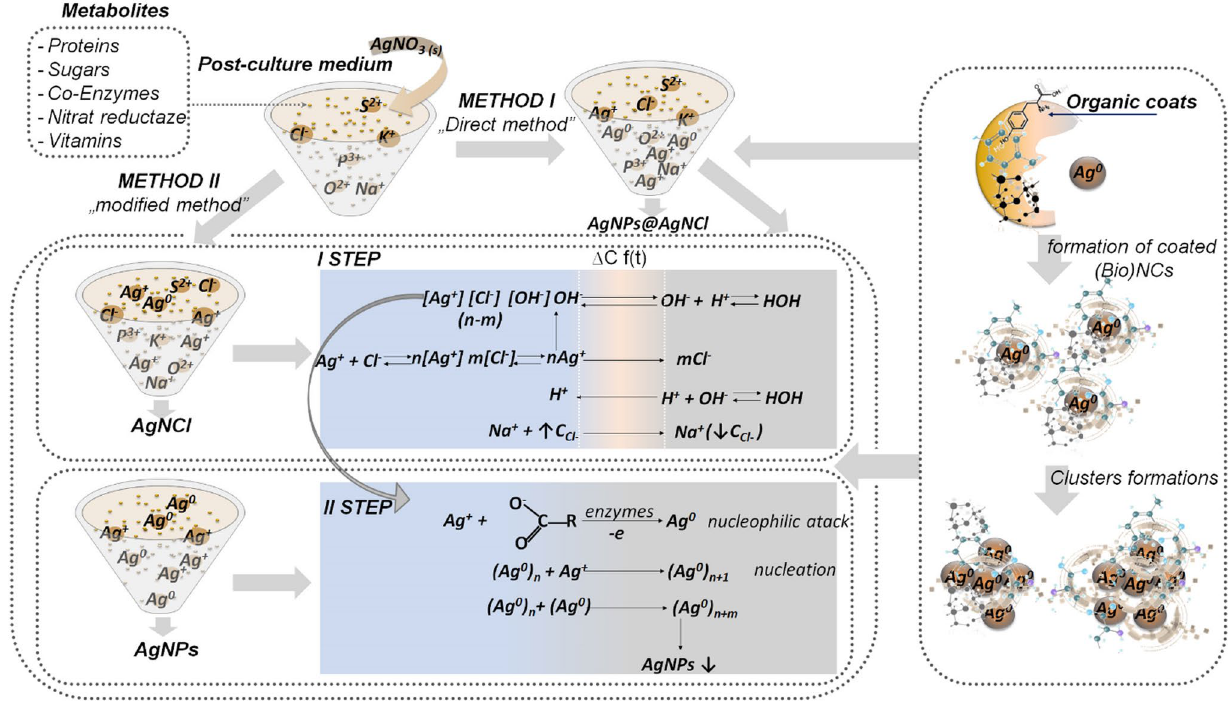
Fig. 12 Scheme illustration presenting the mechanism formations of all mediated (Bio)NCs types by “direct method” and “modified